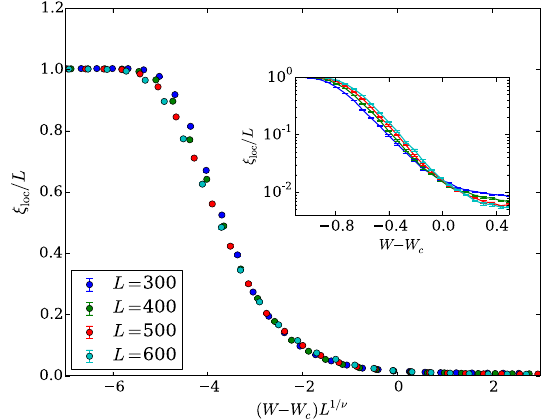
FIG. 2. Finite-size scaling for the disorder-averaged localiza- tion length ξ (defined as the size of the longest resonant cluster loc =L collapse to a universal for a given disorder realization). ξ loc form (main panel) when plotted against the scaling variable ð W − W c Þ L 1 = ν , with correlation length exponent ν ≈ 3 . 5 (cid:2) 0 . 3 . =L curves. Results are averaged Insets show the unscaled ξ loc over ∼ 10 4 disorder